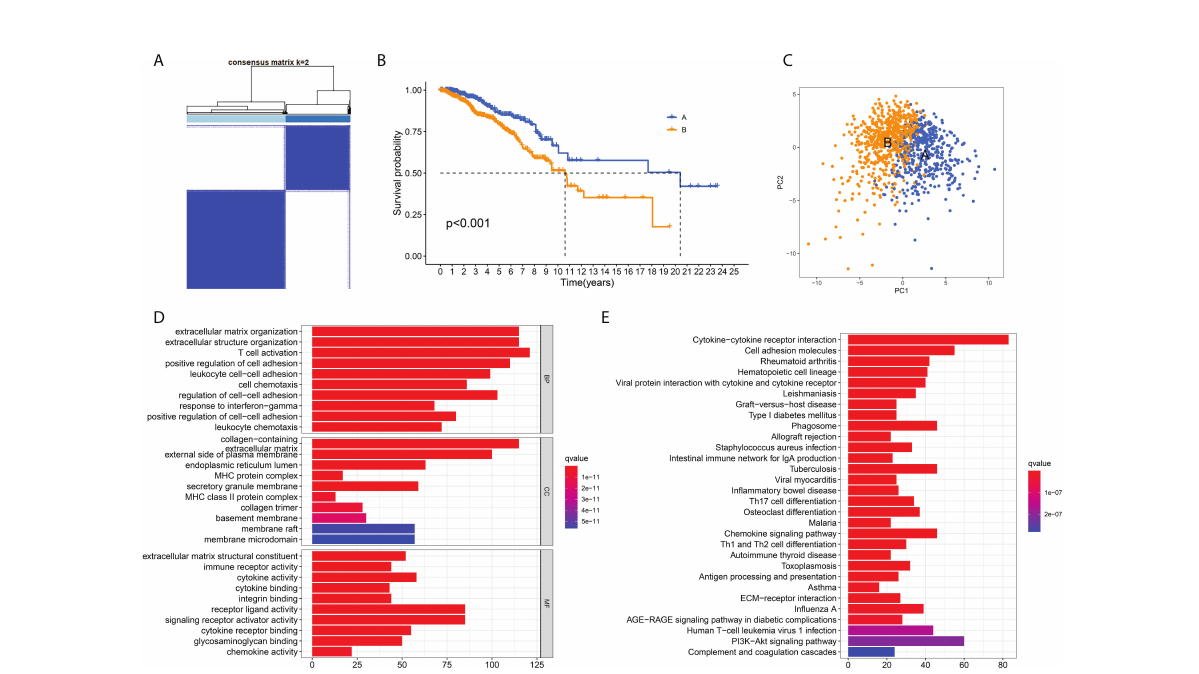
FIGURE 1 Identi fi cation of ECM-clusters in breast cancer based on ECM-associated genes. (A) Breast cancer patients in TCGA database were strati fi ed into two different ECM-clusters according to consensus clustering with k=2. (B) Kaplan-Meier survival analysis demonstrated the prognostic differences between these two ECM-clusters. (C) Dimensionality reduction algorithms of PCA showed that these two ECM-clusters were separately distributed. (D) GO analysis between different ECM-clusters demonstrated the differences in terms of biological processes, cellular components and molecular functions. (E) KEGG analysis demonstrated the differential expression of signaling pathways among ECM-clusters. ECM, extracellular matrix; TCGA, the Cancer Genome Atlas; PCA, principle component analysis; GO, Gene Ontology; KEGG, Kyoto Encyclopedia of Genes and